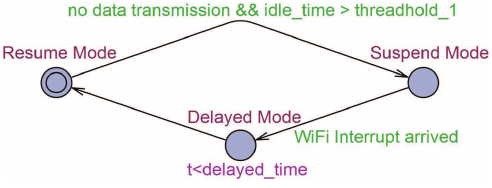
Figure 7. The automata model of optimization approach